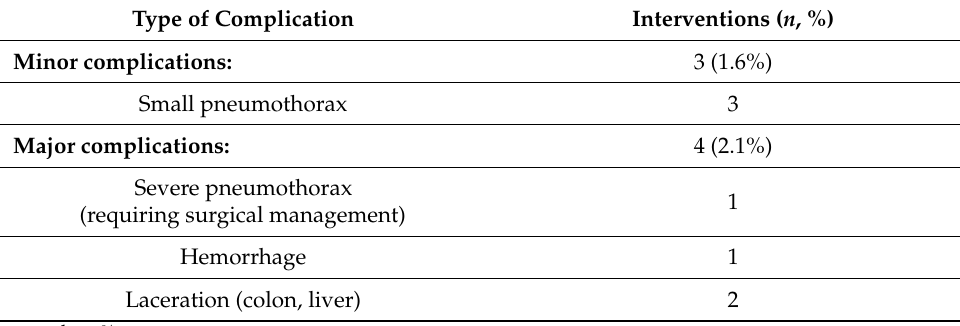
Figure 2. Example of a regular procedure of a CT-guided drainage placement. ( A ) A 64-year-old man with a history of neuroendocrine tumor of the ileum with liver metastasis and previous left side hemihepatectomy. MRI follow-up with hepatobiliary contrast media one year later revealed two new small metastasis in segments 5 and 8 (arrowheads). ( B ) The patient developed fever 5 days after the atypical resection of the liver segments 5 and 8. CT revealed fluid collection and small gas bubbles in the resection cavity, indicating an abscess formation. Arrowheads: resection margins. ( C ) CT fluoroscopic image with drainage (arrow) placement. Arrowheads: resection margins. ( D ) Post- interventional CT control scan. After placement of a 10 F drainage (arrow) and aspiration, the size of the fluid collection becomes significantly smaller. Arrowheads: resection margins. ( E ) MRI follow-up six months later showed unsuspicious resection margins (arrowheads) with granulation tissue. Table 3. Peri-interventional complications according to